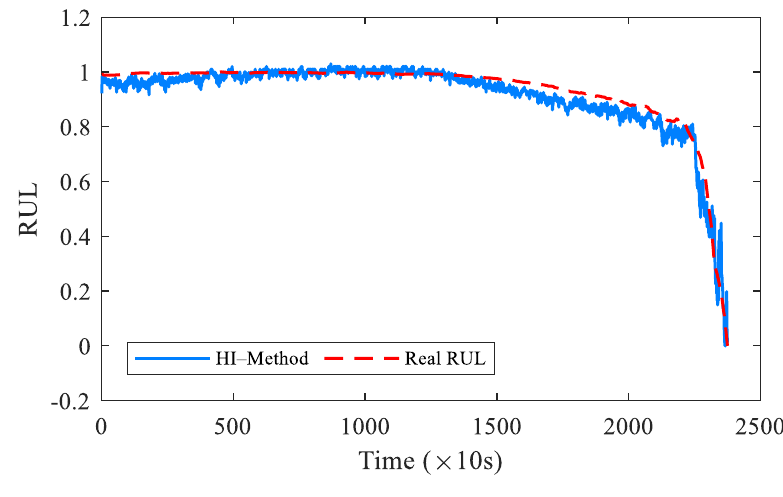
Figure 14. Life prediction results of Bearing1_3. In order to verify the advantages of this method, two common ways of adding labels were selected for comparison. In [41], the method of adding labels in Figure 12a